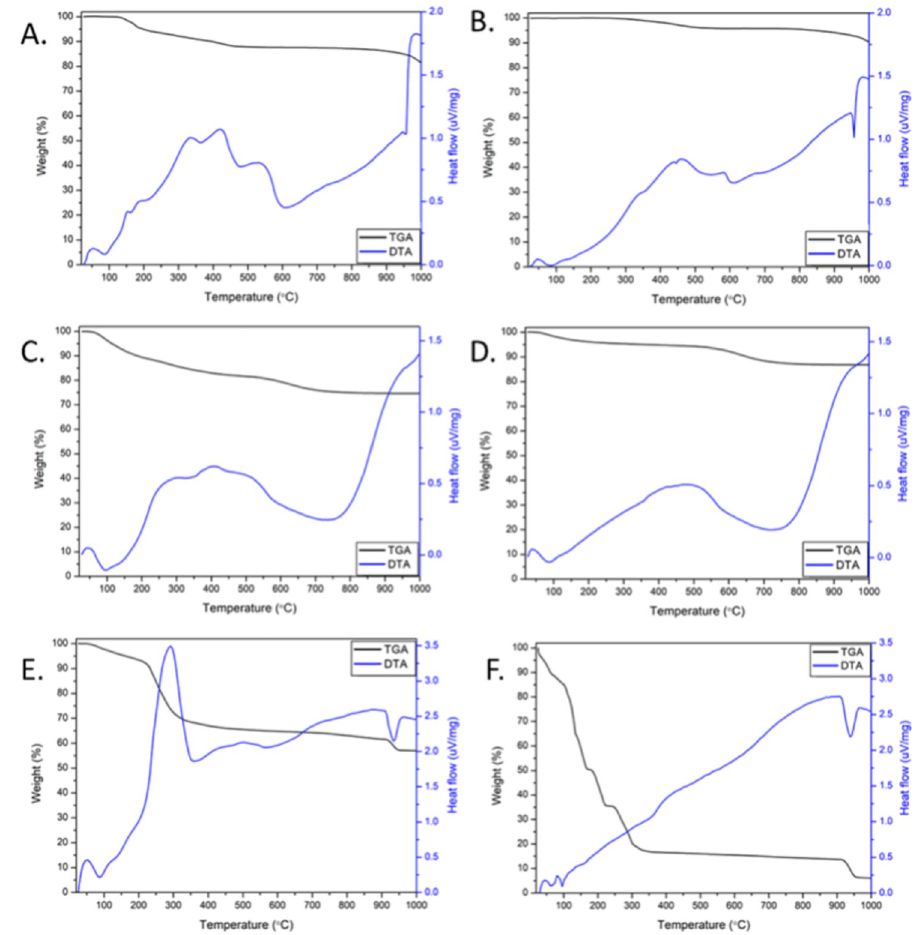
Fig 5. Thermogravimetric analysis of the prepared nanomaterials. (A) Ag NPs before calcination, (B) Ag NPs after calcination, (C) TiO2 NPs before calcination, (D) TiO2 NPs after calcination, (E) Co(OH)2 NMs (before calcination), (F) Co3O4 NMs (after